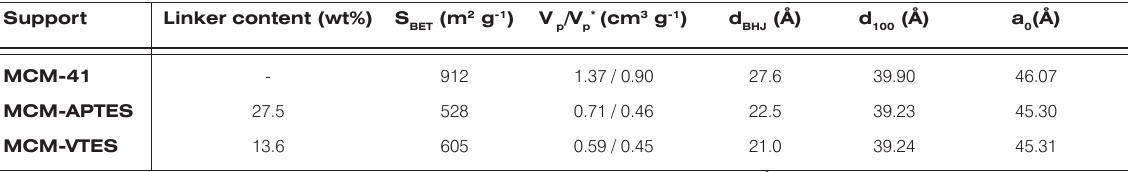
Table 1. Relevant parameters characterizing the structural and textural features of the mesoporous silica supports. Support